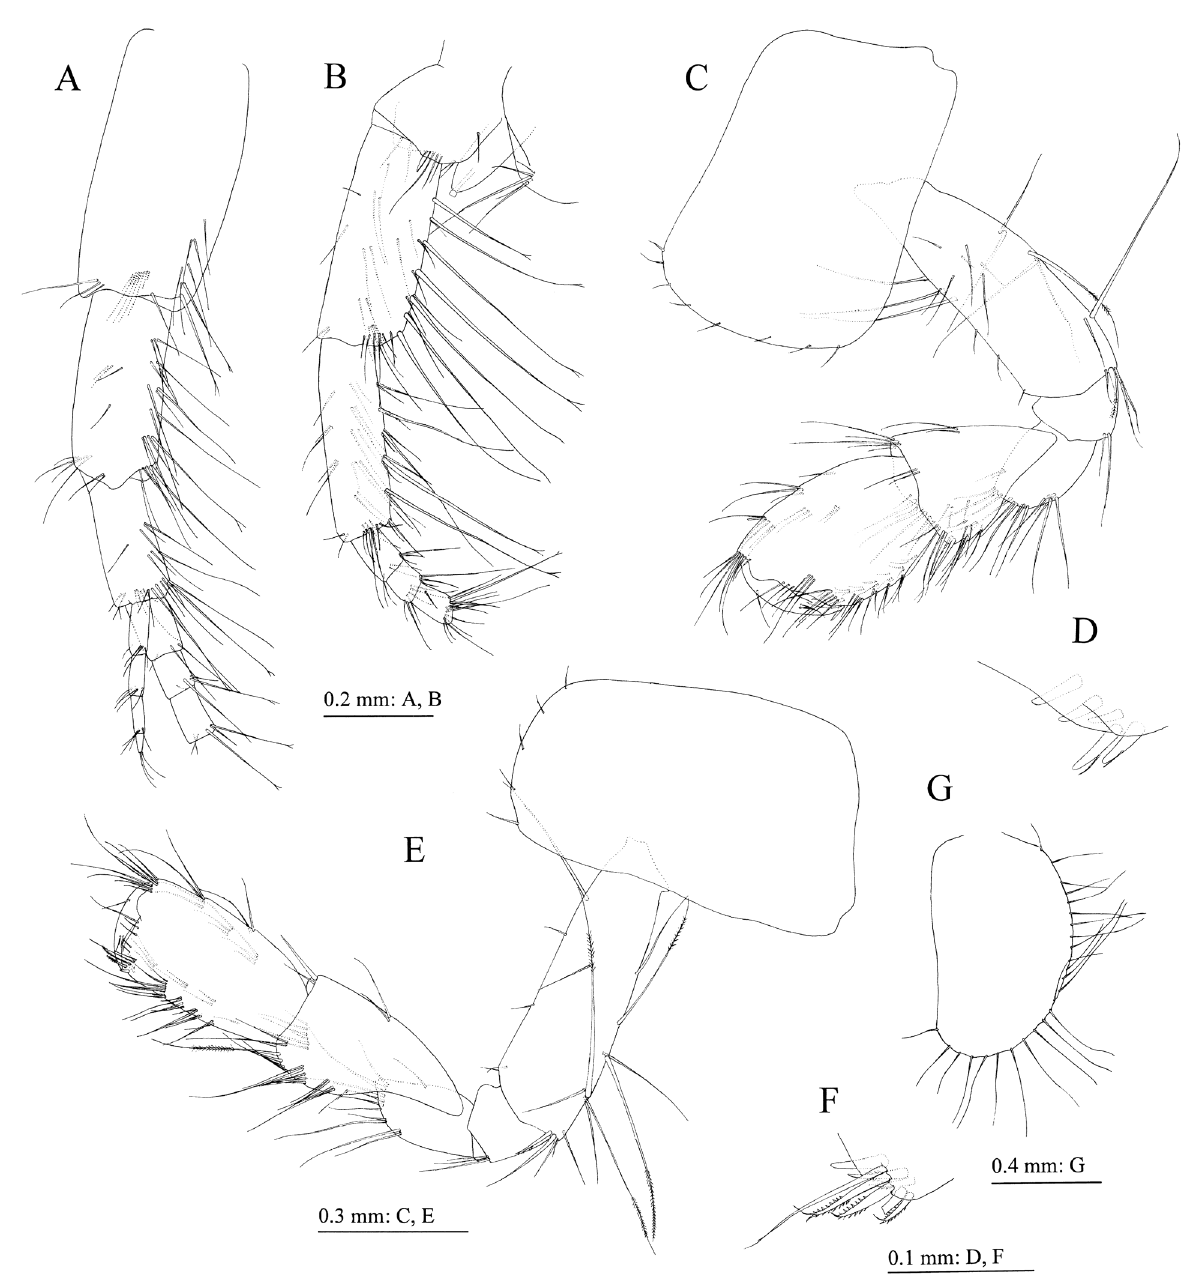
Figure 6. Jesogammarus bousfieldi sp. n., paratype, female (6.6 mm), NSMT-Cr 25471. A peduncular articles 1–3, accessory fla - gellum, and flagellar articles 1–3 of antenna 1, medial view; B peduncular articles 1–5 and flagellar articles 1–3 of antenna 2, medial view; C gnathopod 1, lateral view; D palmar margin of propodus of gnathopod 1, lateral view; E gnathopod 2, lateral view; F palmar margin of propodus of gnathopod 2, lateral view; G brood plate of gnathopod 2, lateral